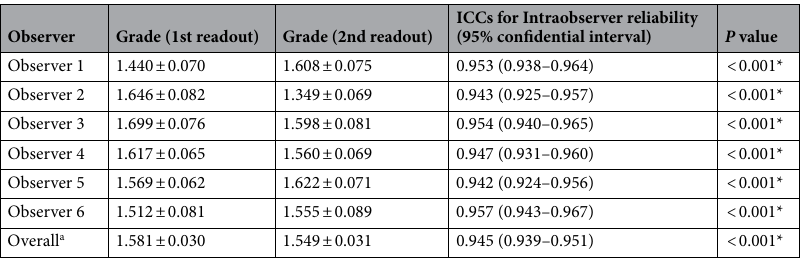
Table 1. Intraobserver reliability in the first and second readouts. Data are shown as mean ± standard deviation. * P < 0.05. ICC = Intraclass correlation coefficient. a ICCs for the data set of 1254 total grades (209 images × 6 observers).